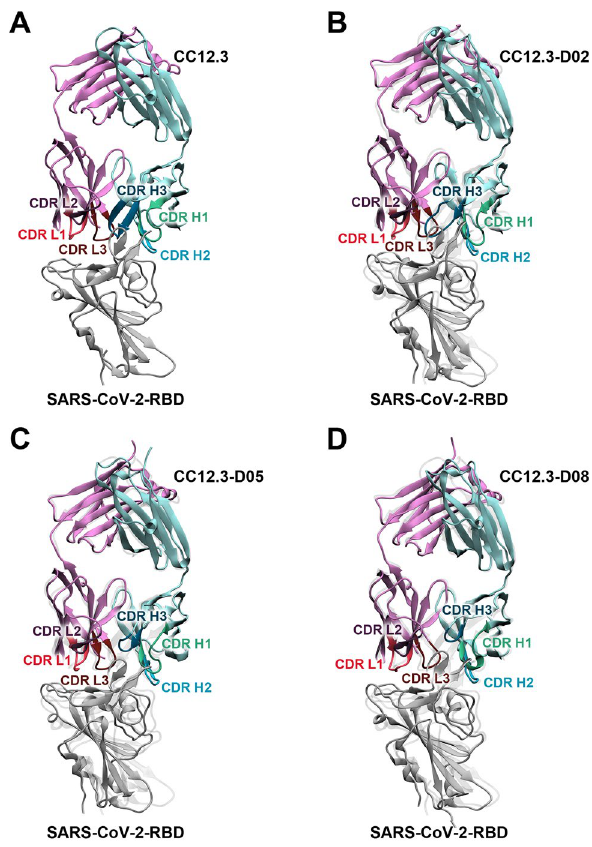
Figure 1. Overall structures of the heavy chain (light blue) and light chain (purple) of ( A ) CC12.3, ( B ) CC12.3-D02, ( C ) CC12.3-D05, and ( D ) CC12.3-D08 binding to SARS-CoV-2-RBD (gray). CDRs H1, H2, H3, L1, L2, and L3 are colored in green, blue, dark green, dark pink, dark purple, and dark red, respectively. The designed Fabs CC12.3/SARS-CoV-2-RBD were superimposed with Fab CC12.3/SARS-CoV-2-RBD (light